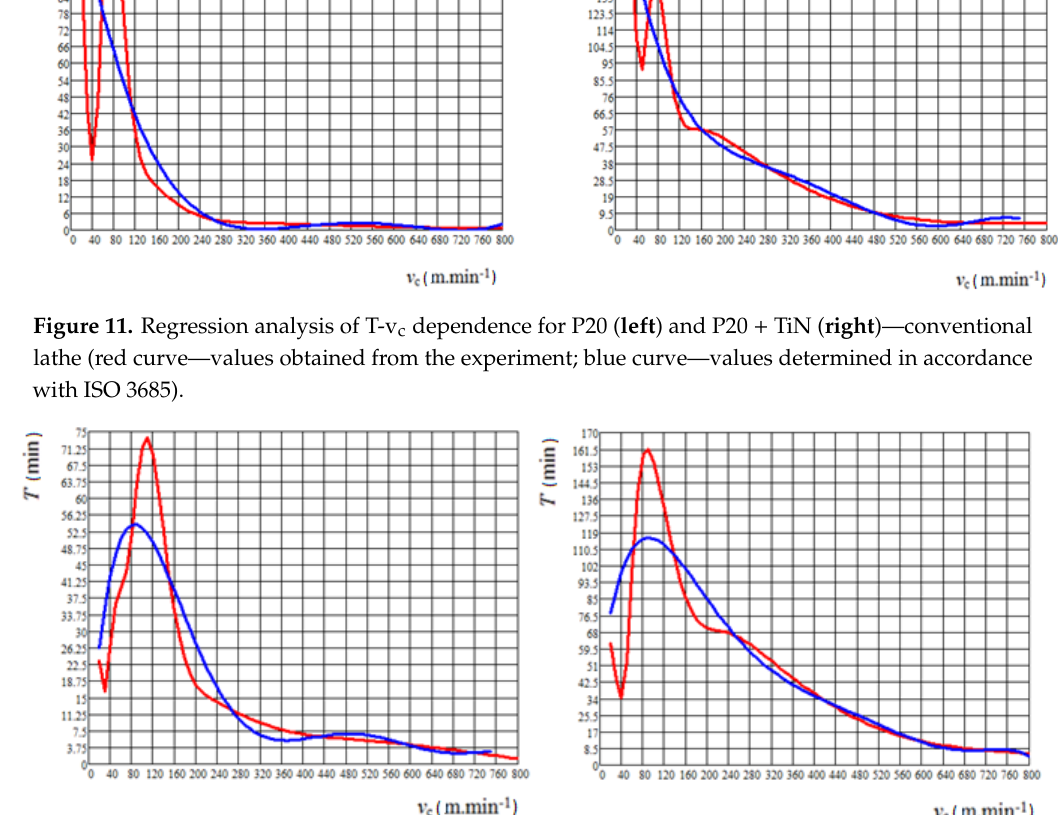
Figure 12. Regression analysis of T-v c dependence for Al 2 O 3 ( left ) and Al 2 O 3 +TiN ( right )—conventional lathe (red curve—values obtained from experiment; blue curve—values determined in accordance with ISO 3685).